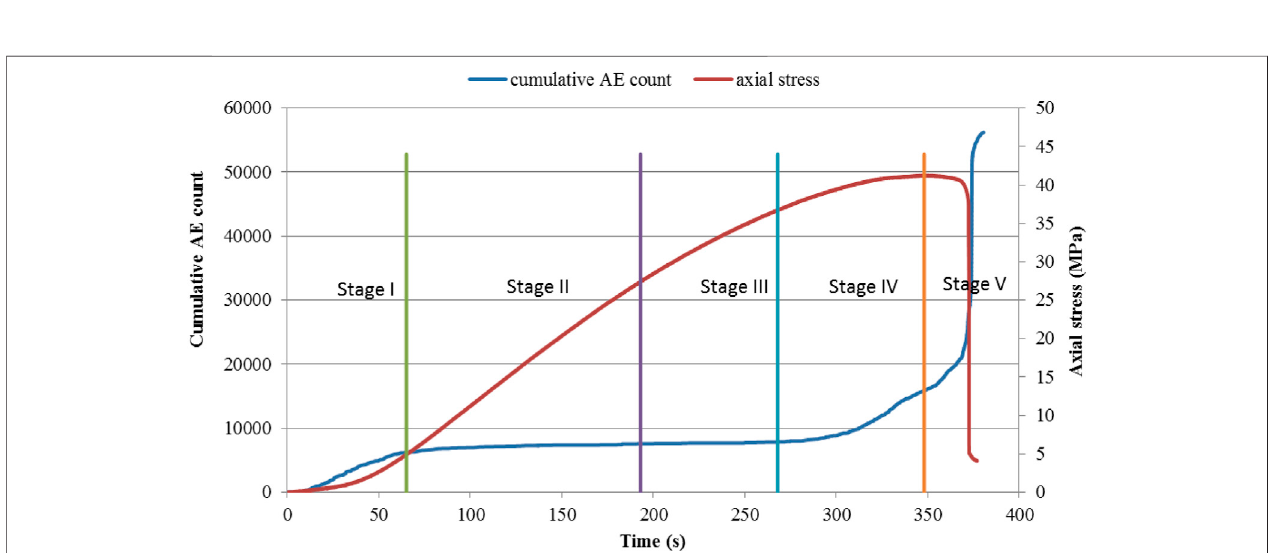
FIGURE 8 | (A) Longitudinal cracks parallel to the direction of applied load. (B) Specimen after test.